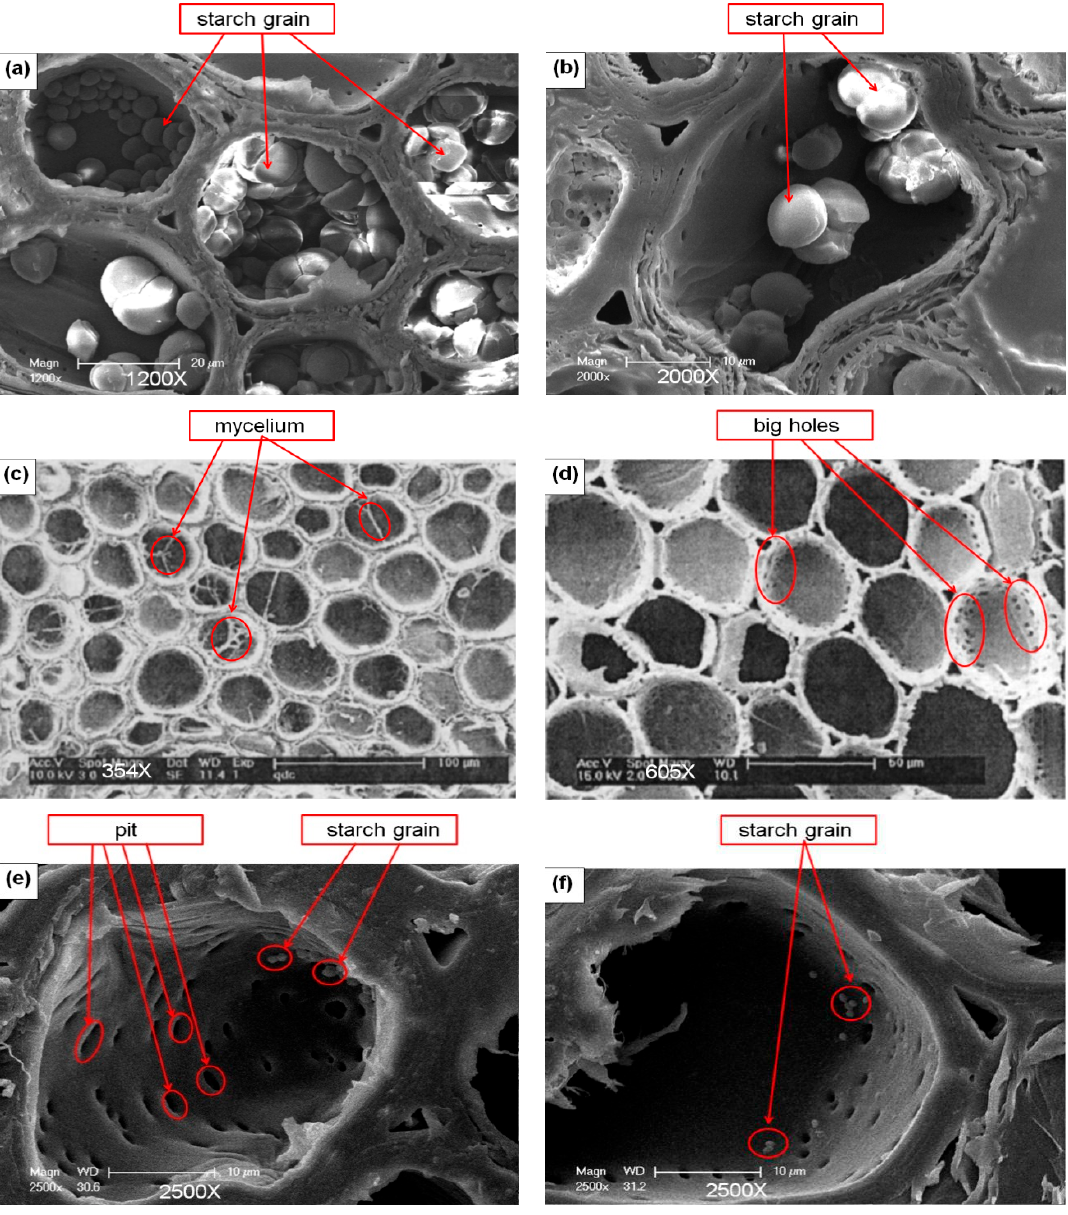
Figure 4. Environment scanning electron microscope (ESEM) images of bamboo cells. ( a , b ) Control samples; ( c , d ) specimens after three and 15 weeks of decay, respectively (from Qin [33]); ( e , f ) specimens of the used